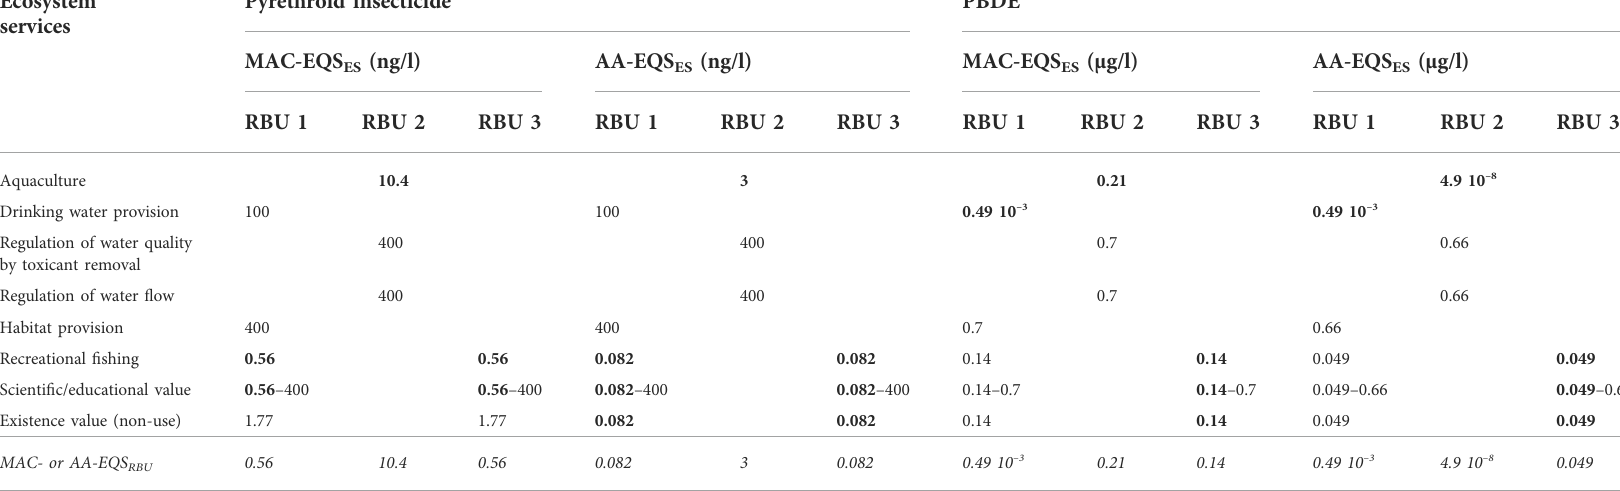
TABLE 7 MAC-EQS ES and AA-EQS ES values for a pyrethroid insecticide and a PBDE for three hypothetical river basin units (RBU 1, RBU 2, RBU 3). Values in bold denote the critical EQS ES values, which are used to derive the overall MAC-EQS RBU and AA-EQS RBU for each river basin given in the bottom row of the table. Ecosystem